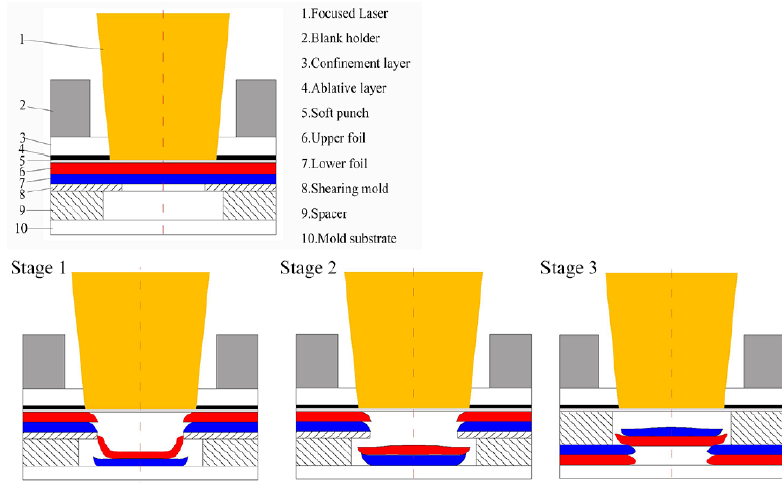
Figure 1. Schematic diagram of micro-shear clinching by laser shock.